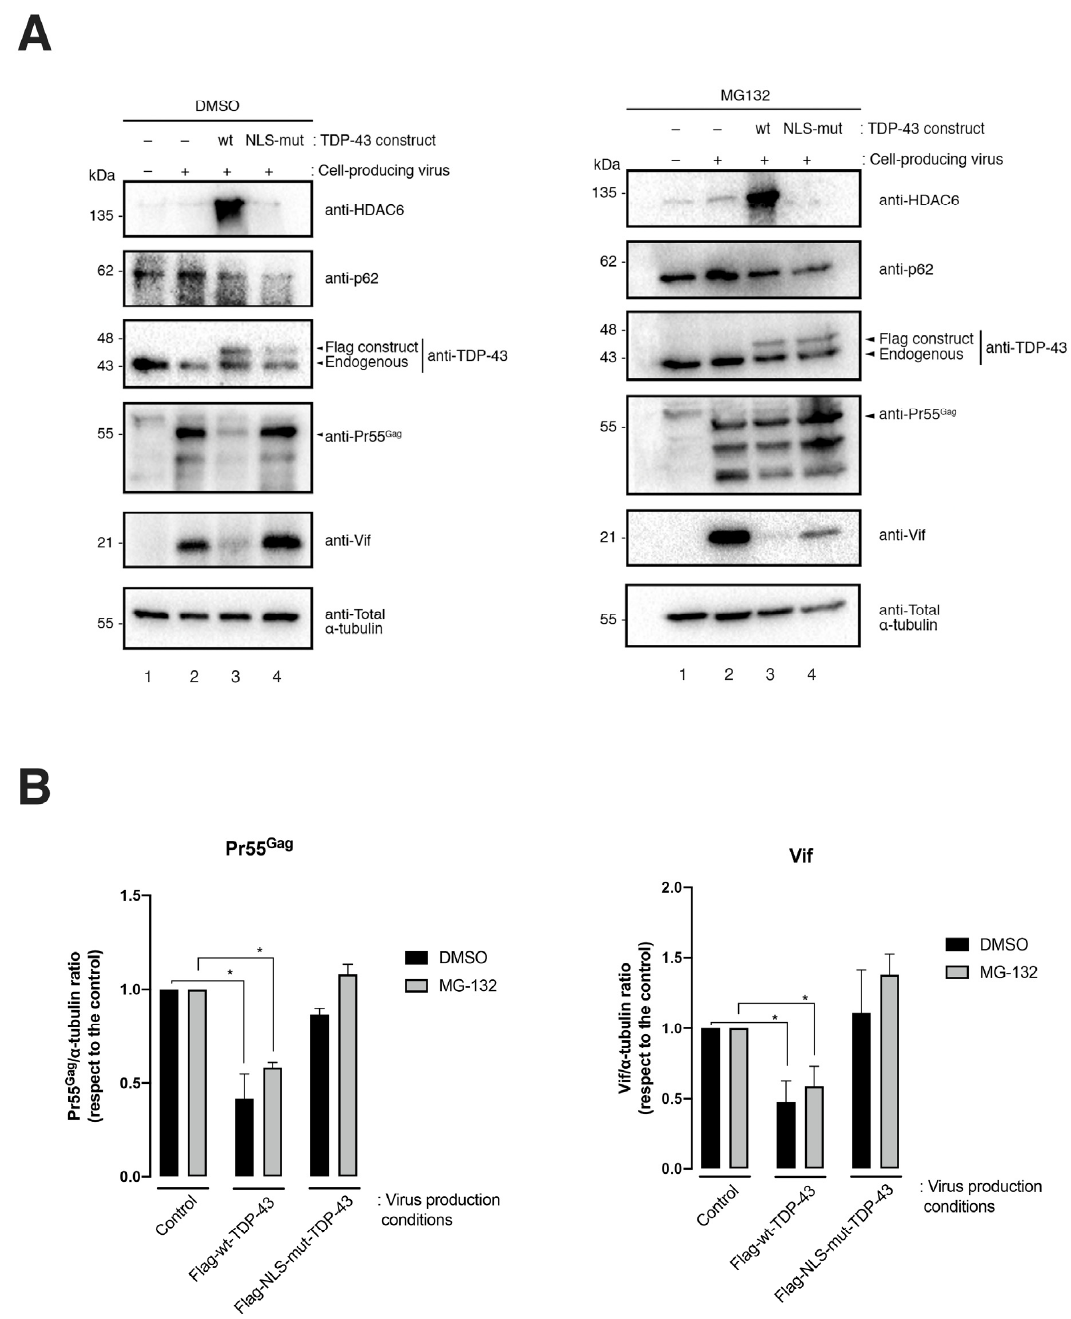
Figure 5. TDP-43 mediated clearance of the HIV-1 Pr55 Gag and Vif viral proteins does not occur by the proteasome pathway. ( A ) The biochemical western blot analysis of HIV-1 Pr55 Gag and Vif degradation together with HDAC6 and p62 protein expression levels in virus-producing HEK-293T cells transfected with Flag-wt-TDP-43 or Flag-NLS-mut-TDP-43, treated or not with the proteasome chemical inhibitors MG-132 (20 µM). DMSO is the vehicle control. Total α -tubulin for protein load control is shown under each experimental condition. A representative experiment of three is shown (see replicate data in Figure S5, Supplementary Materials section). ( B ) Histograms show the quan- tification of western blot bands for the Pr55 Gag /or Vif/ α -tubulin ratio under inhibitor (MG132) or control (DMSO) experimental conditions. Data associated with the quantification of replicates are shown in Figure S5, Supplementary Materials section. Data are represented as the mean ± S.E.M. of three independent experiments. When indicated, * p < 0.05 is the p value for Student’s t